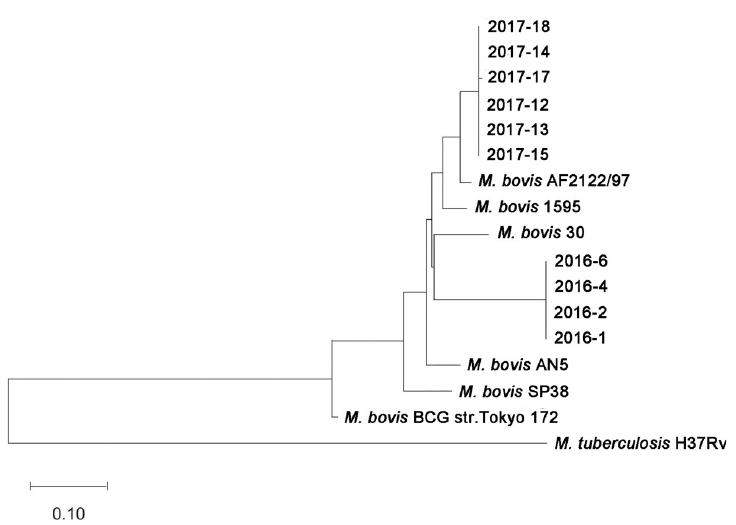
Fig 4. Phylogenetic trees of ten isolates. The optimal tree with the sum of branch length = 1.71277593 was shown in Fig 4. The evolutionary distances were calculated using the Maximum Composite Likelihood method and were in the units of the number of base substitutions per site. This analysis involved 17 nucleotide sequences. All ambiguous positions from each sequence pair were removed (pairwise deletion option). There were a total of 3,914 positions in the final dataset. Evolutionary analyses were conducted in MEGA 5.